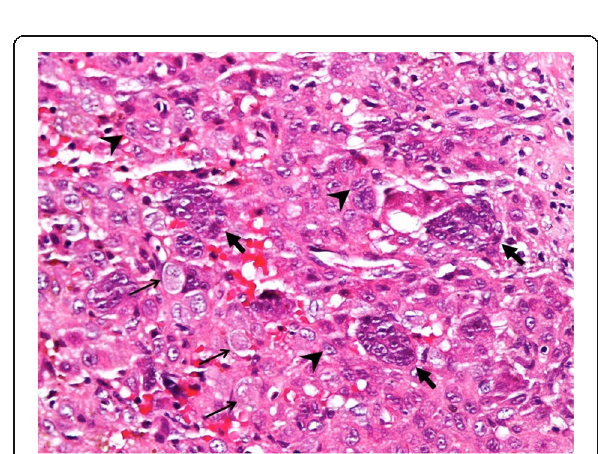
Fig. 3 H&E staining at × 400 magnification shows proliferation of stromal mononuclear cells mixed with variable numbers of multinucleated giant cells (arrows). The multinucleated giant cells exhibit vesicular nuclei with prominent nucleoli that are similar to those seen for stromal cells (mononuclear stromal cells are present between multinucleated giants with several examples of stromal cells indicated by arrowheads). Rounded macrophage-like cells can also be seen (thin